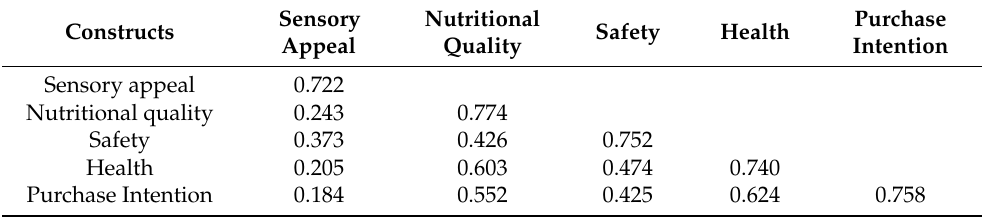
Table 3. Discriminant validity of the